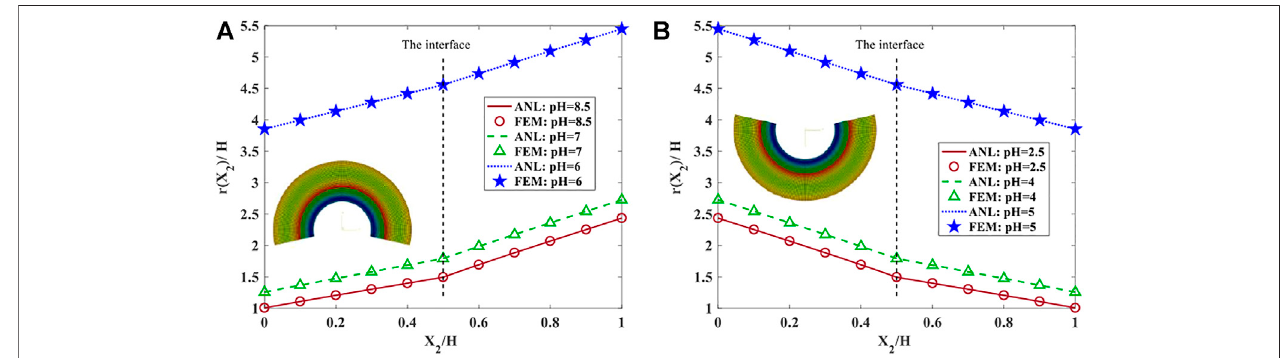
FIGURE5| Thecomparisonofdeformationinhydrogelbilayerwith N ] (cid:1) 0 . 001 (A) atpH6 , 7 , and8 . 5aswellas (B) pH5 , 4 , and2 . 5usingbothanalyticalsolution and fi nite element analysis.